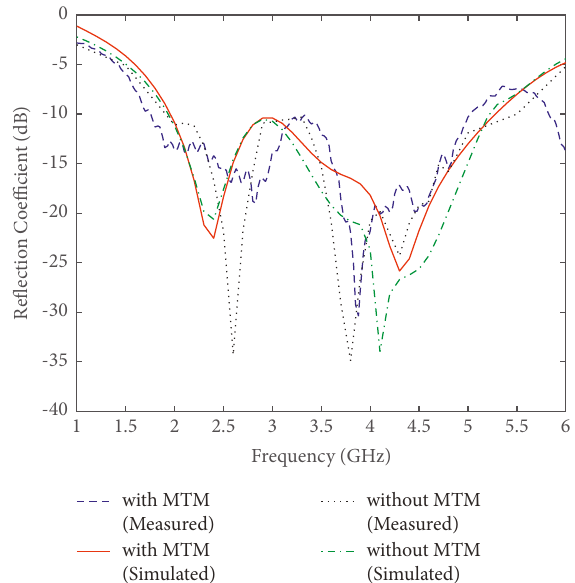
Figure 10: Simulated and measured reflection coefficient curves with and without